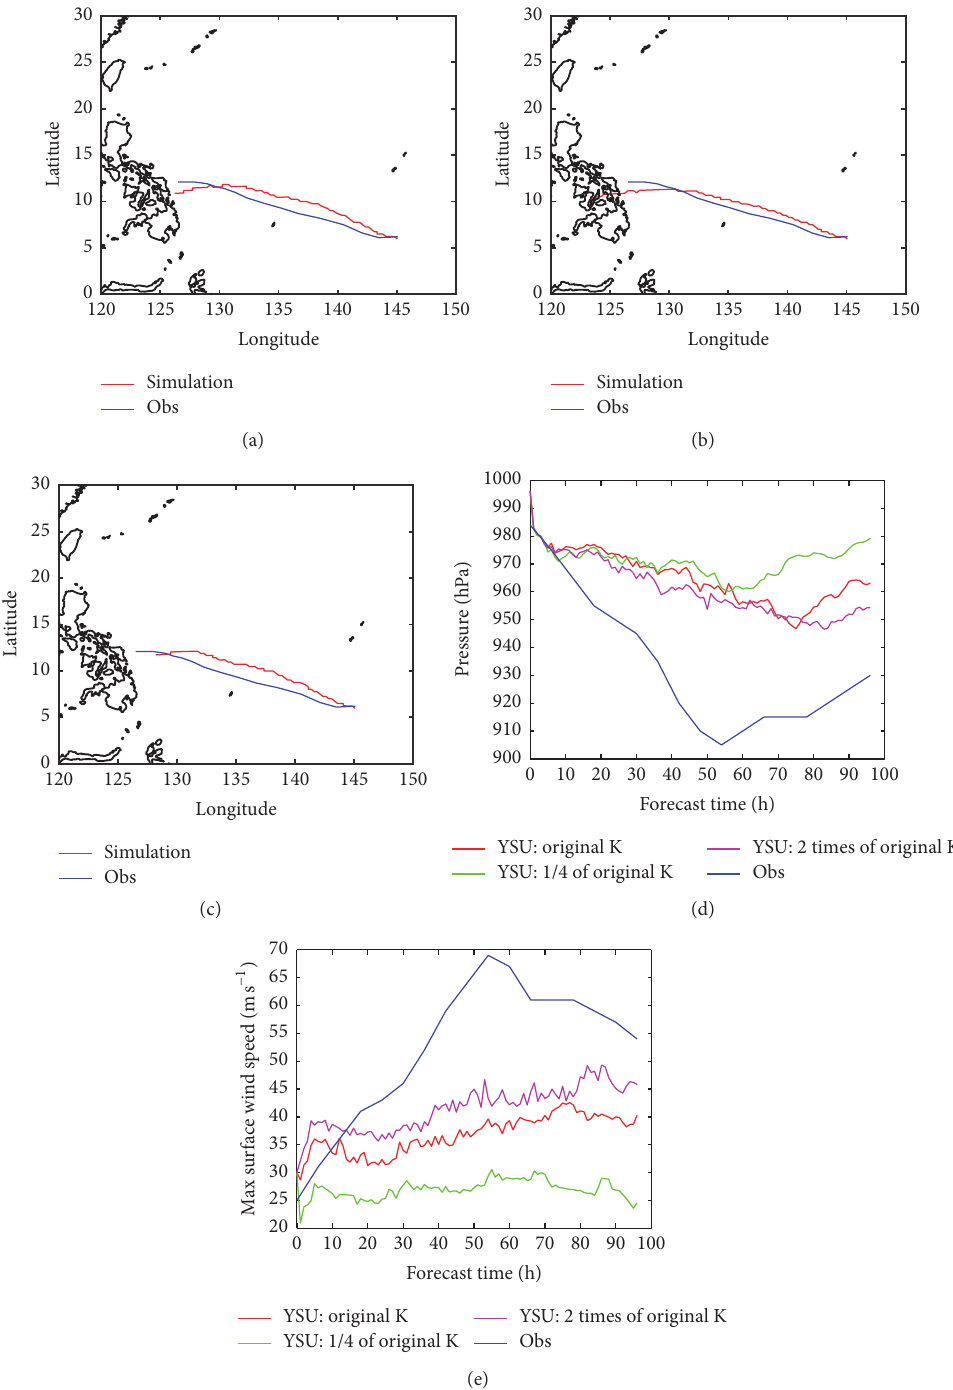
Figure 8: Case 7-Hagupit: (a) track simulated by the original YSU; (b) track simulated by the K025; (c) track simulated by the K200; (d) comparisons of center sea-level pressure; and (e) comparisons of maximum surface wind speed.